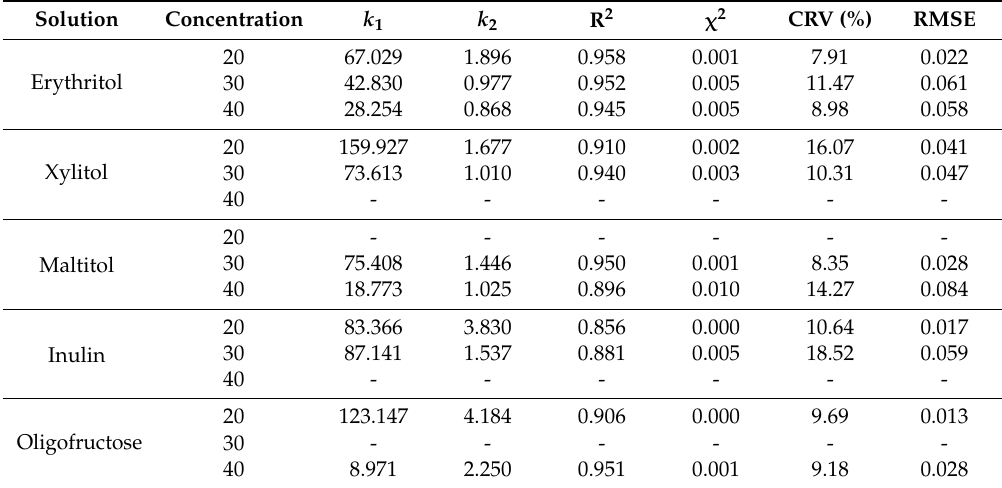
Table 6. Values of k 1 , k 2 , R 2 , χ 2 , CRV and RMSE of modeling SG using Peleg’s model. Solution